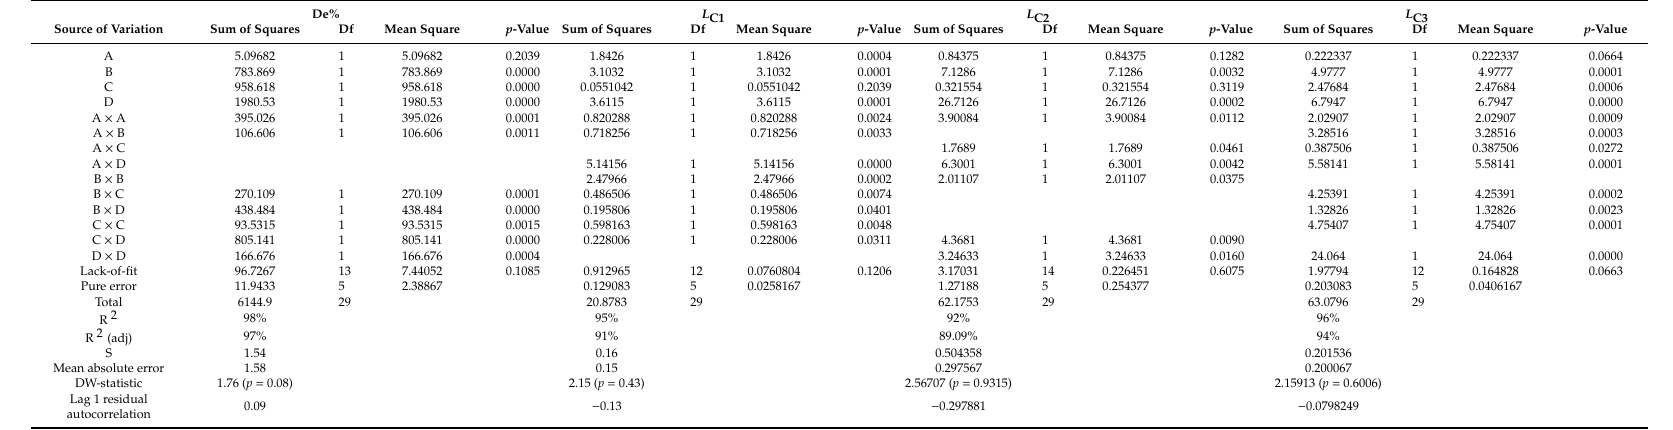
Table 3. Analysis of variance: reduced models of the four